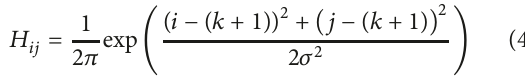
distance, and Delaunay triangulation can be obtained by N iterations. All triangle of the common point is recorded, the circle center of the triangle is found, and the clockwise connection of the center of the center is the corresponding Thiessen Polygon. The time complexity of the triangle is the complexity of the polygon. The algorithm flow is as